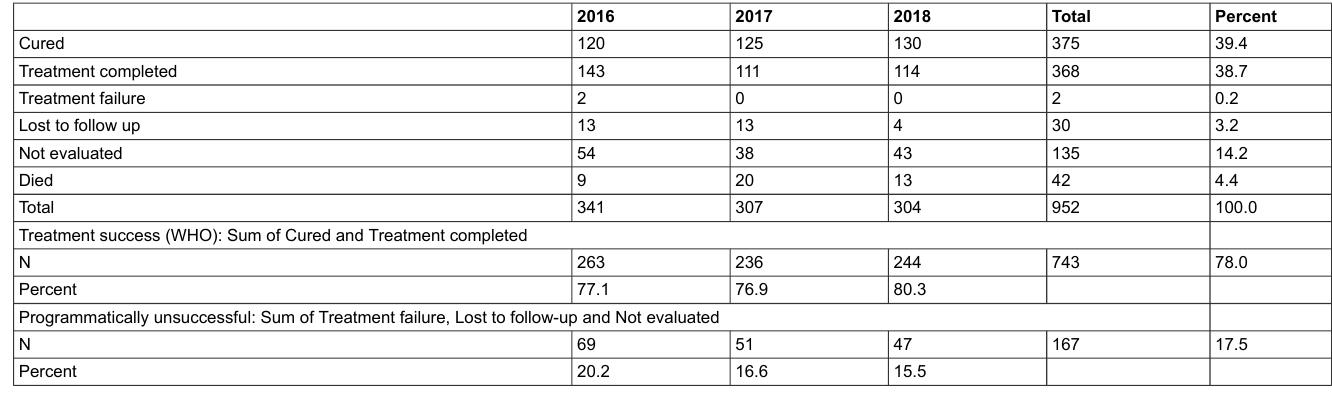
Table 4: Treatment outcome monitoring according to WHO standards among pulmonary culture-positive, rifampicin-susceptible tuberculosis cases, Switzerland and Liechtenstein,